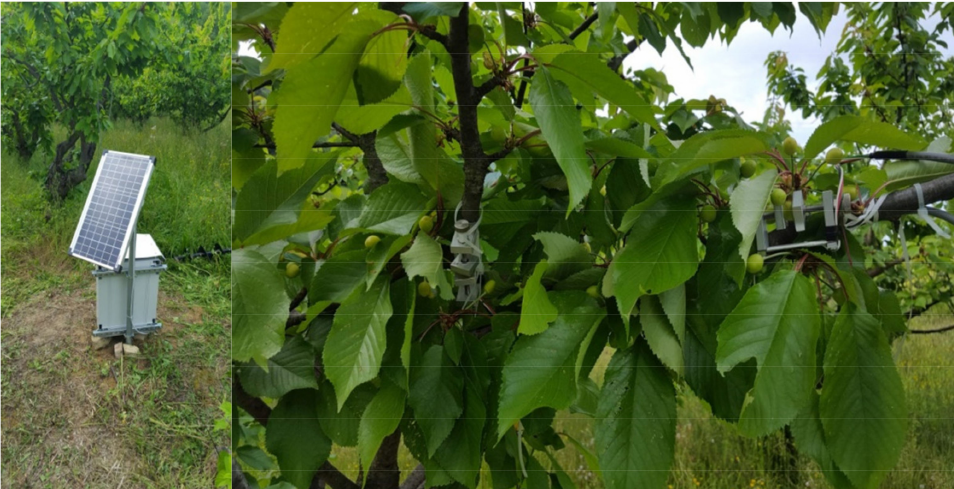
Figure 1. Acquisition system, with a CR100X datalogger (Campbell Scientific Inc., Logan, UT, USA) and an automatic extensometer DEX20 (Dynamax Inc., Huston, TX,